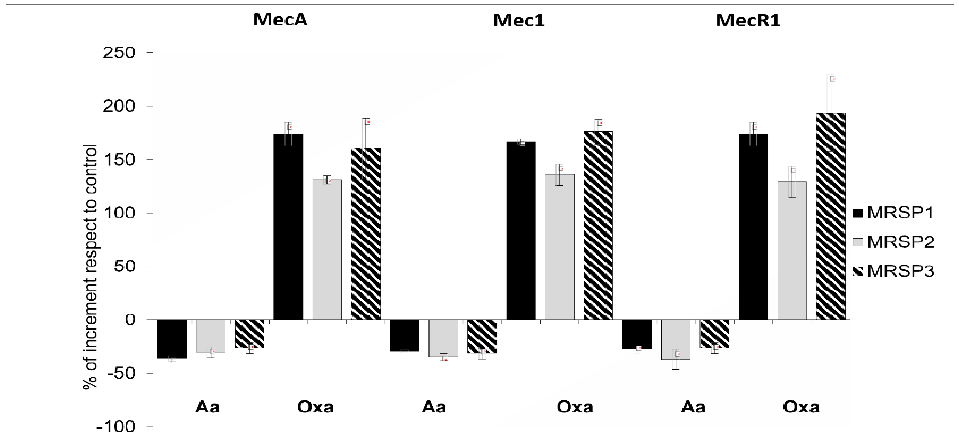
Figure 2. Relative expression of genes of mec operon in MRSP strains treated with subinhibitory concentration of abietic acid (16 mg/mL for MRSP1 and MRSP3, and 32 mg/mL for MRSP2) and 1 mg/mL oxacillin. Values represent the mean ± SD for three independent experiments. MRSP1: veterinary methicillin-resistant S. pseudintermedius strain; MRSP2 and 3: human methicillin-resistant S. pseudintermedius strains. Aa: abietic acid; Oxa: oxacillin.